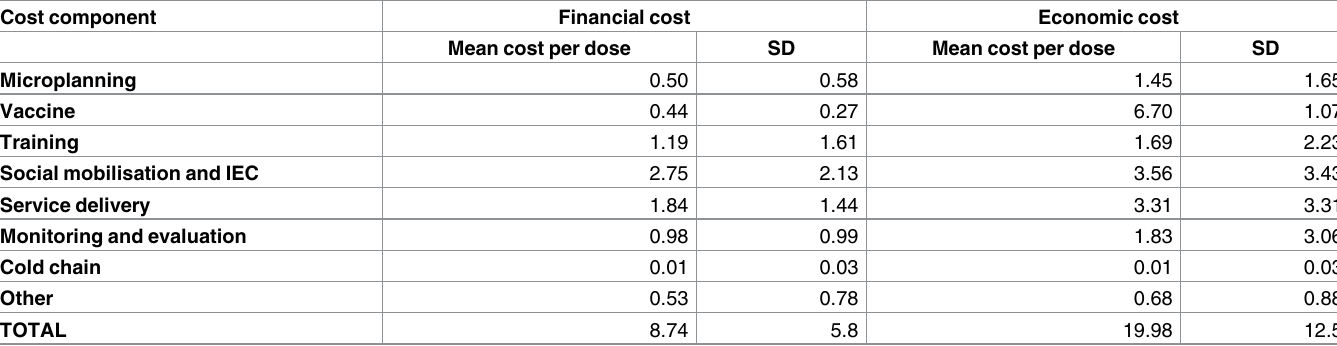
Table 5. Breakdown of economic and financial cost per HPV vaccine dose in demonstration project countries, 2014 US$. Cost